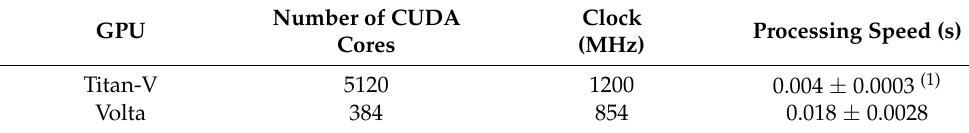
Figure 8. Inference times of maturity estimations for detected tomatoes by frame. Table 3. Processing speed of tomato maturity estimation with two